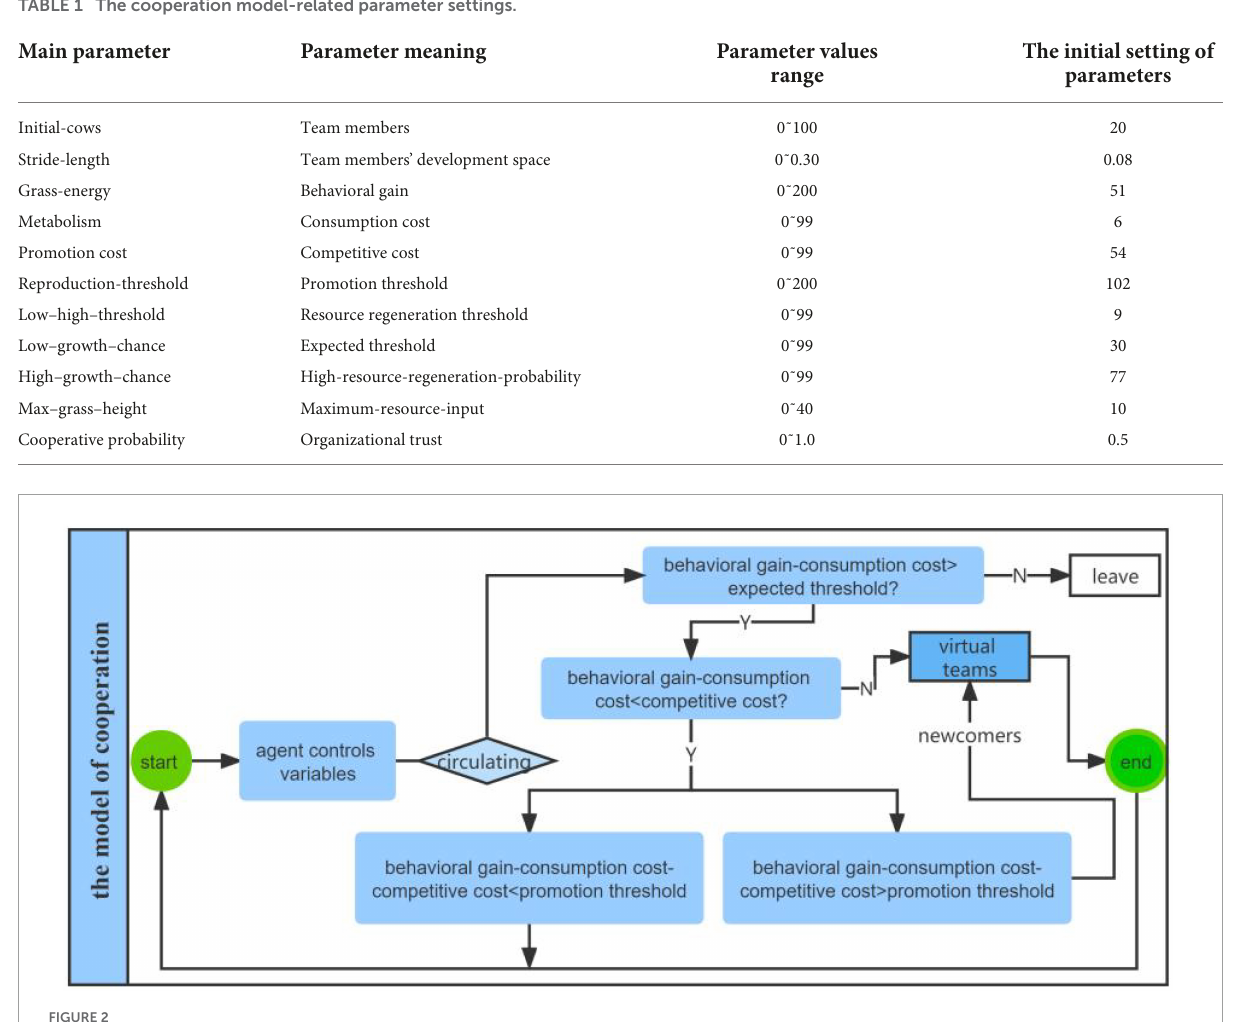
FIGURE2 Schematic diagram of the running logic of the model of